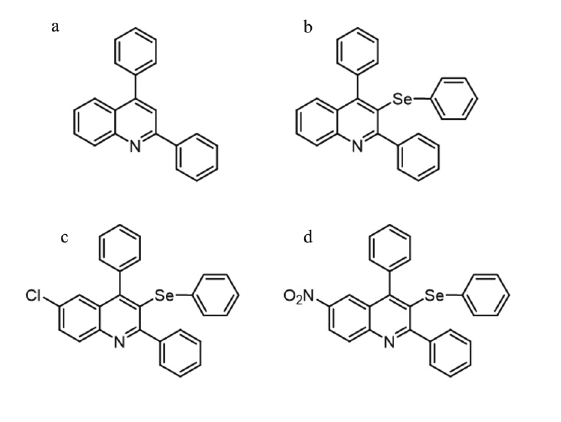
Figure 1 - Chemical structure of quinoline derivatives. (a) 2,4-diphenylquinoline; (b) 2,4-diphenyl-3-(phenylselanyl) quinoline; (c) 6-chloro-2,4-diphenyl-3-(phenylselanyl) quinoline; (d) 6-nitro-2,4-diphenyl-3-(phenylselanyl)